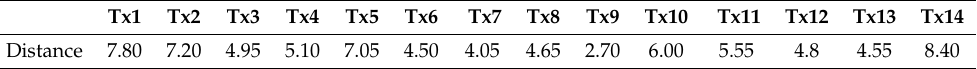
Figure 6. Tx and Rx antennas in positions Tx1 ( left ) and Tx14 ( right ) in LOS and OLOS, respectively. Table 2. Distance between the Tx antenna and the center of the URA (in